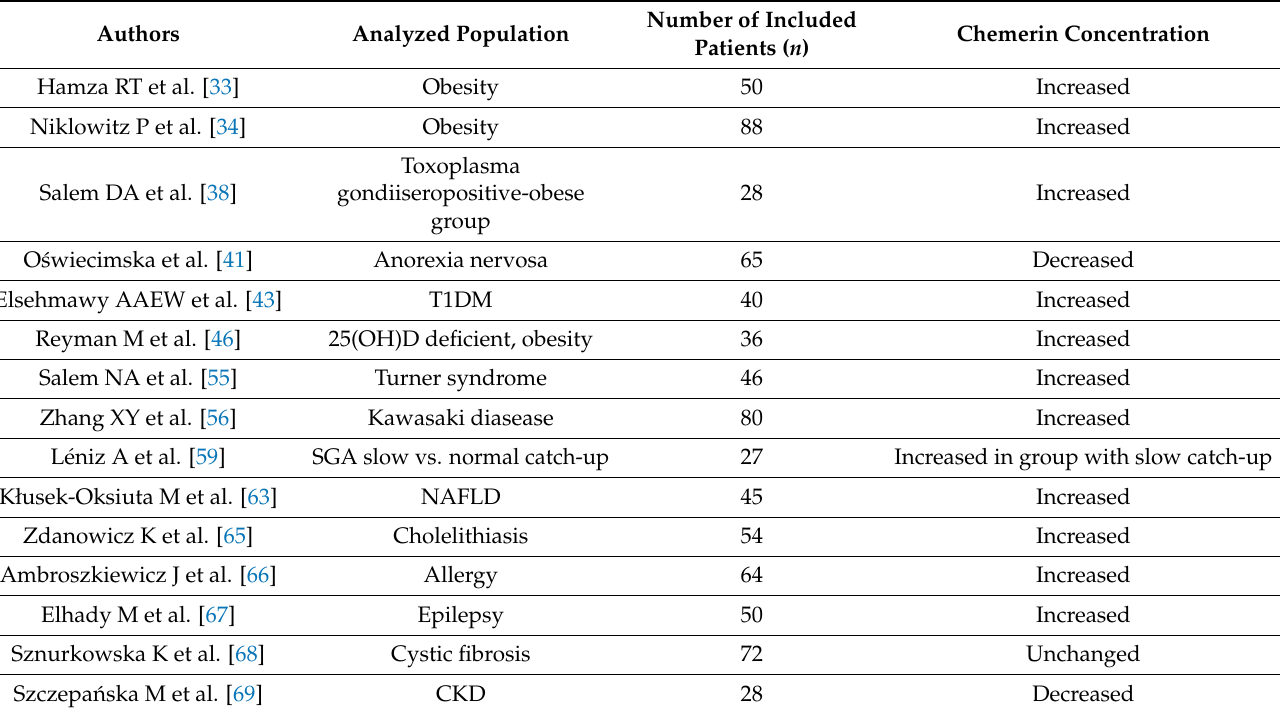
Table 1. Chemerin concentrations reported in children based on selected research